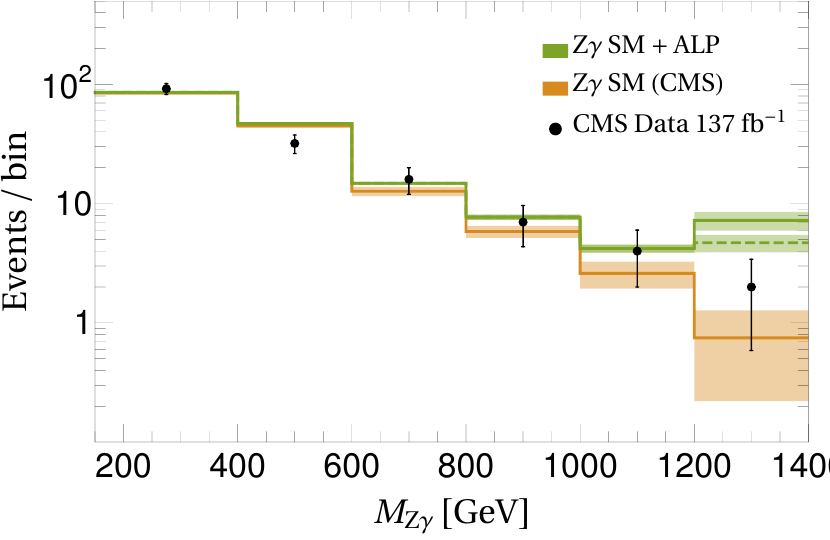
Figure 8 . M Zγ distribution for the pp → jjZγ → jj‘ + ‘ − γ channel. The data points and the total SM background (orange) are taken from the measurement in ref. [54]. The last bin contains the overflow events. The dashed and solid green lines show the total ALP EW VBS signal for c /f a = c /f a = 1 TeV − 1 with a cut of M Zγ < 2 TeV and 4 TeV , respectively. e B e W